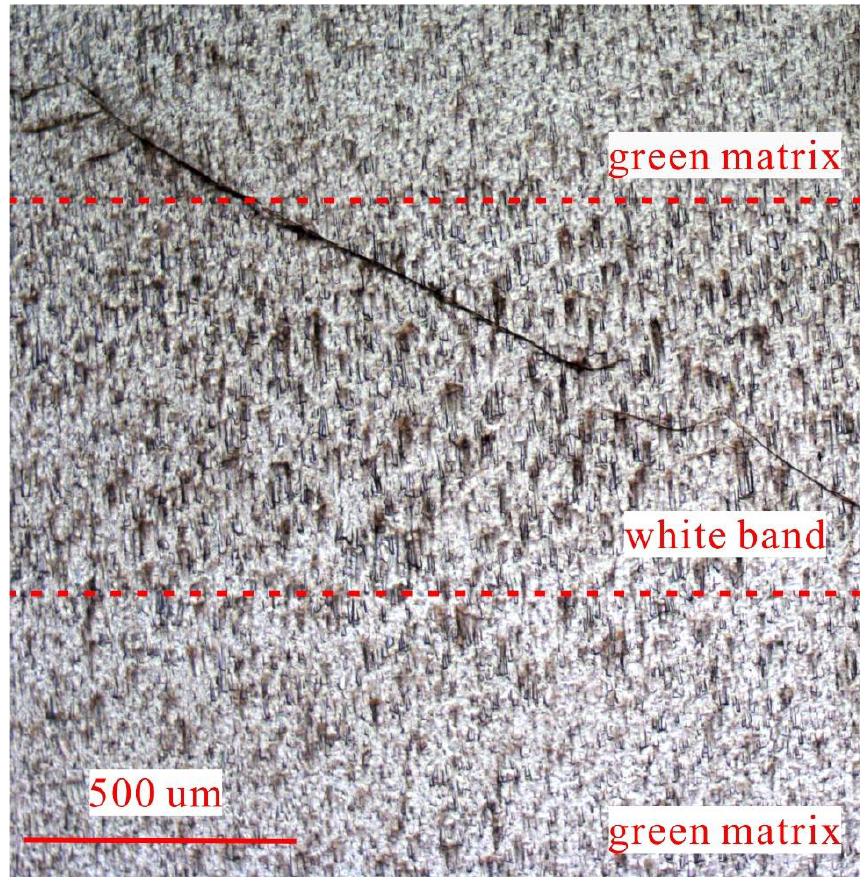
Figure 3. Microscopic image of cabochon specimen S 1 of Lvwen stone under 50× magnification.